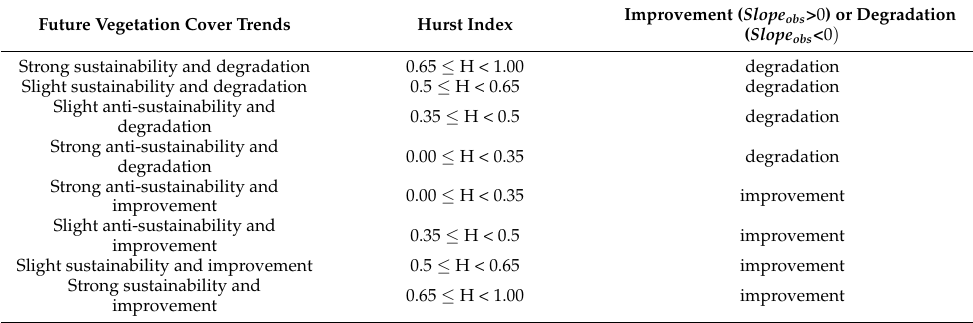
Table 10. Classification of future vegetation-cover change trends.